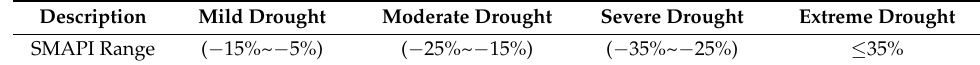
Table 1. Drought degrees based on